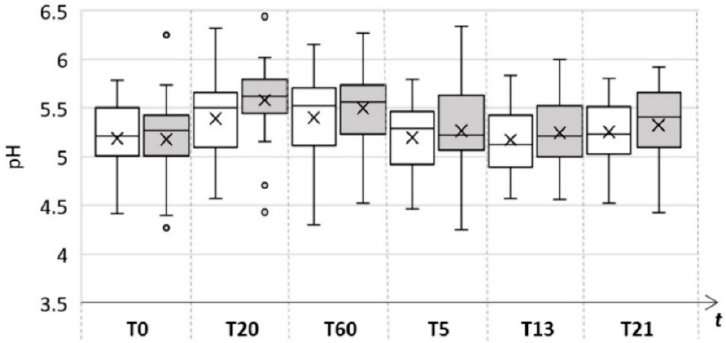
Figure 5. pH measurements of the control and test area in the short-term and long-term study (grey boxes are test values, white are control).